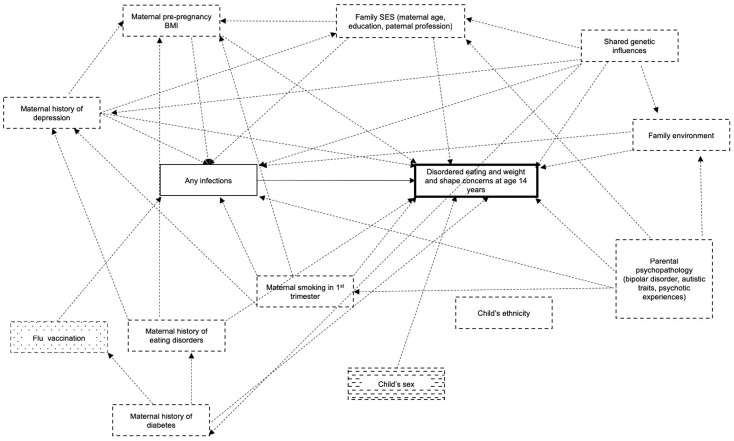
Direct Acyclic Graphs describing the causal assumptions for our analytical models.